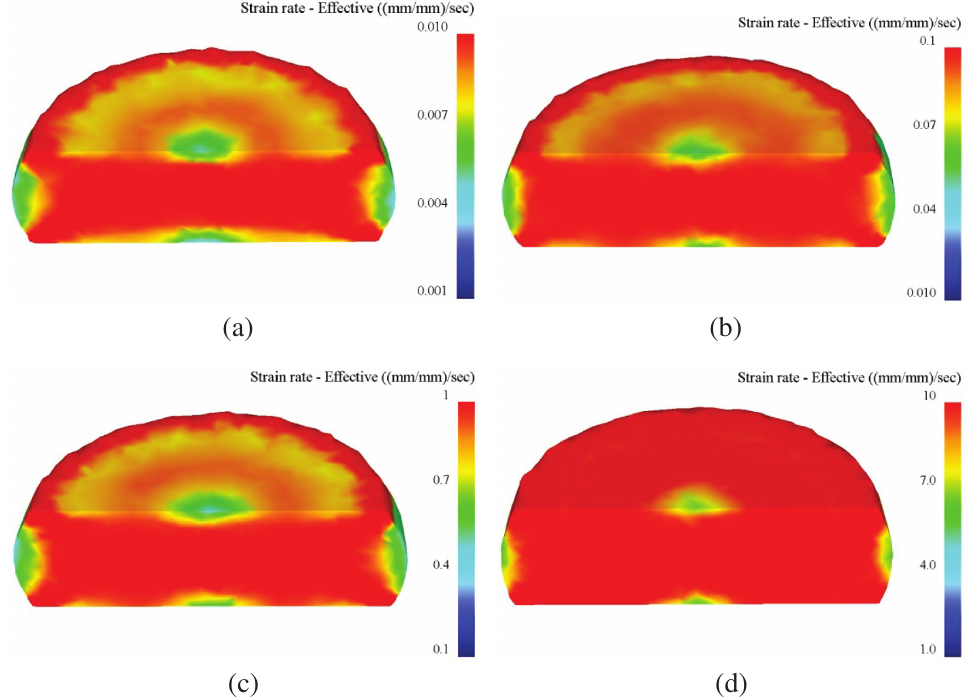
Figure 12: The effective strain rate distributions under the temperature of 1203K and strain rate of (a) 0.01s − 1 , (b) 0.1s − 1 , (c) 1s − 1 and (d) 10s − 1